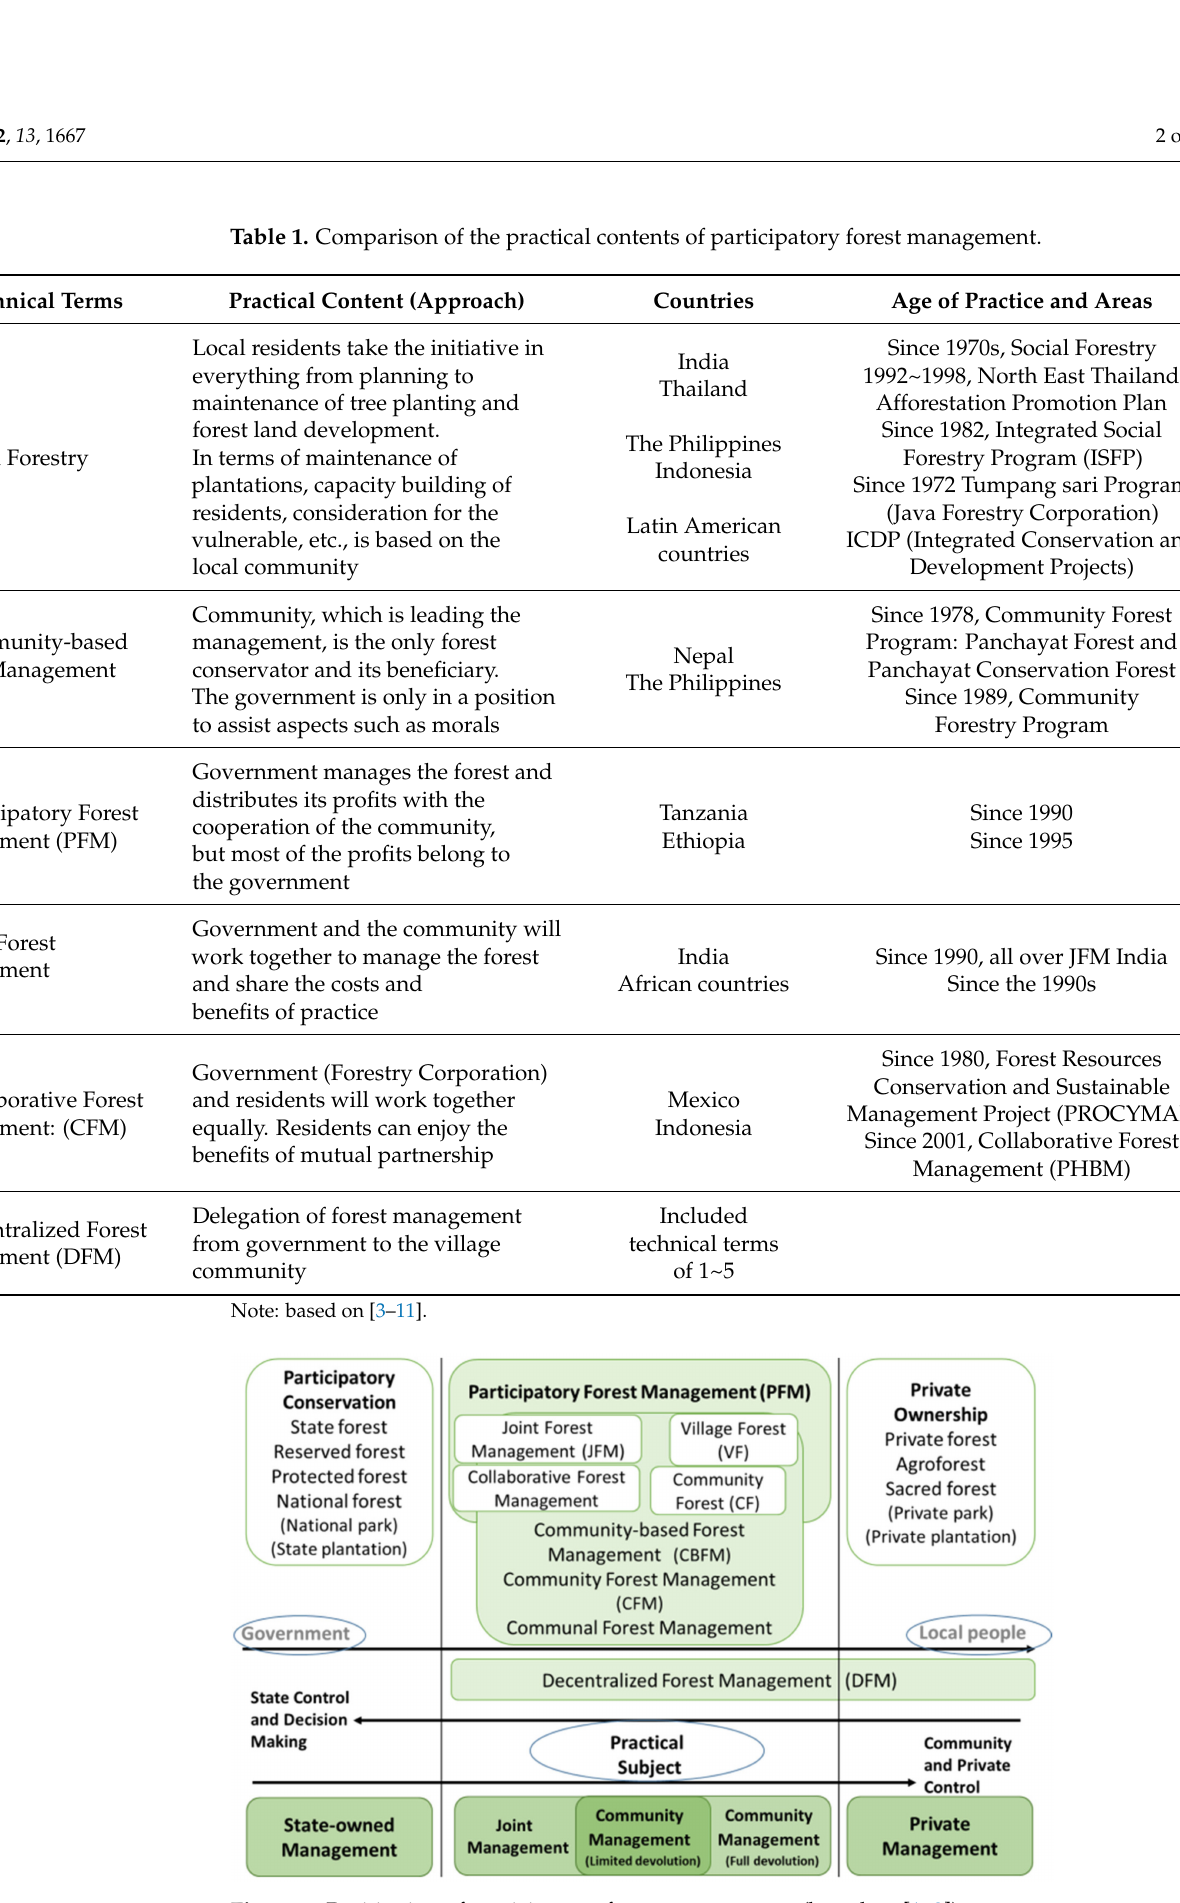
Figure 1. Positioning of participatory forest management (based on